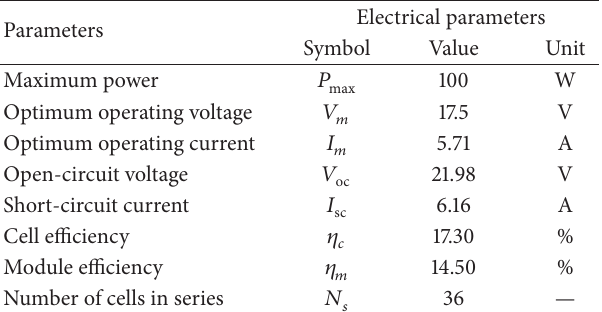
Table 1: ZDNY-100C36 series PV